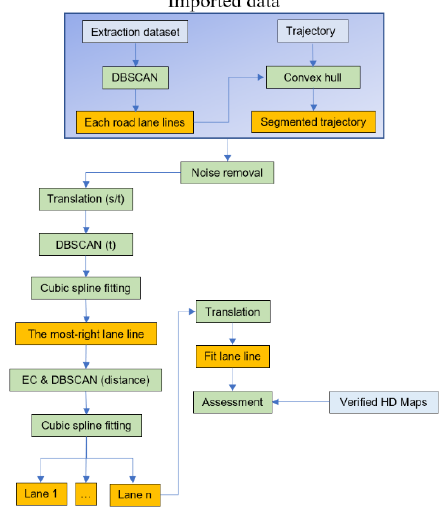
Figure 4. The flowchart of lane line modelling